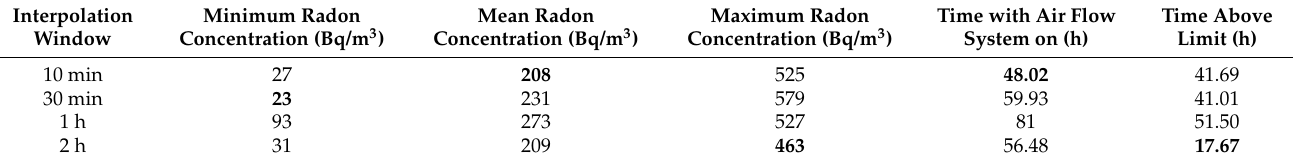
Mean Radon Concentration (Bq/m 3 )